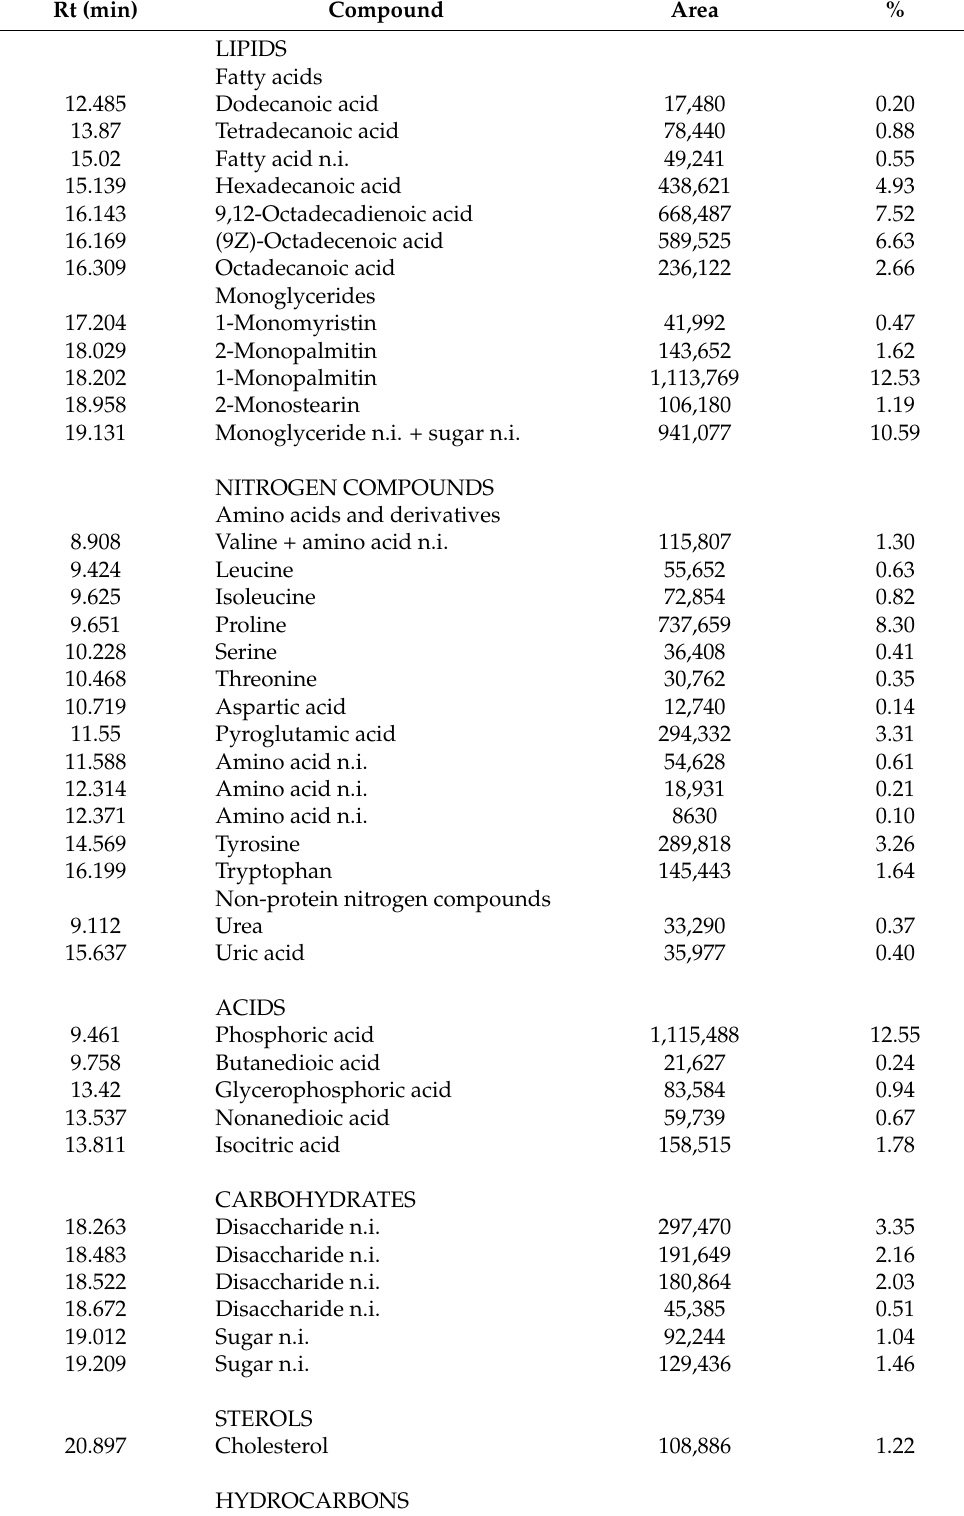
Table 1. GC-MS characterization of mealworm ( Tenebrio molitor )